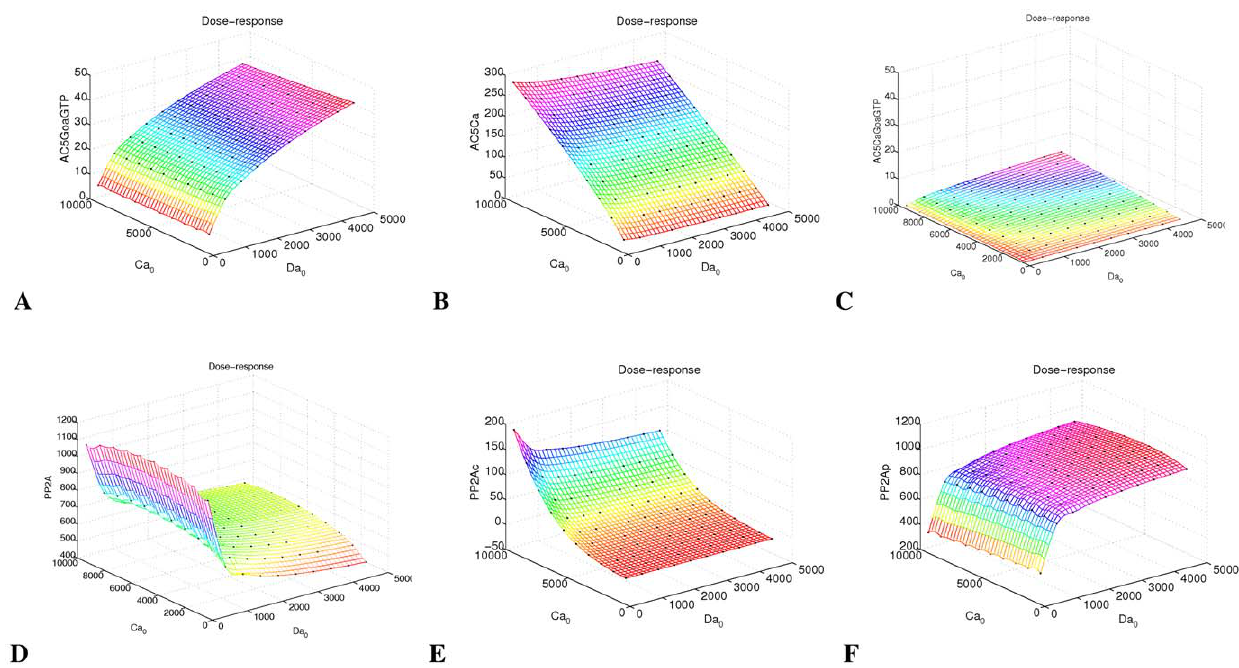
Figure 5. Dependence of target species on Ca and Da inputs. The 2D psf shows species which segregate to only one of the input pathways ( A , B , F ), a species which remains unresponsive ( C ), and species which show some signal integration in their input constellation ( D , E ).